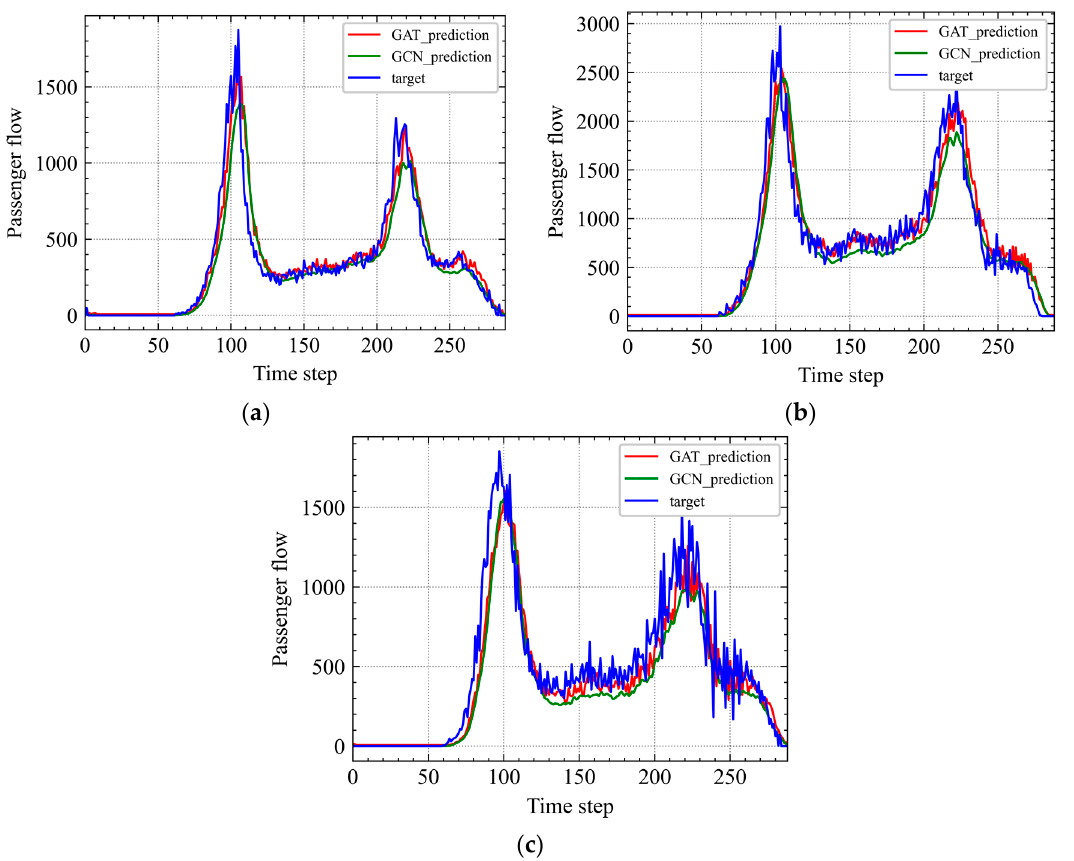
Figure 8. Comparison of predictions with the passenger flow target on the graph flow dataset of Shanghai metro system. ( a ) CA, ( b ) SRS, and ( c ) XZ.